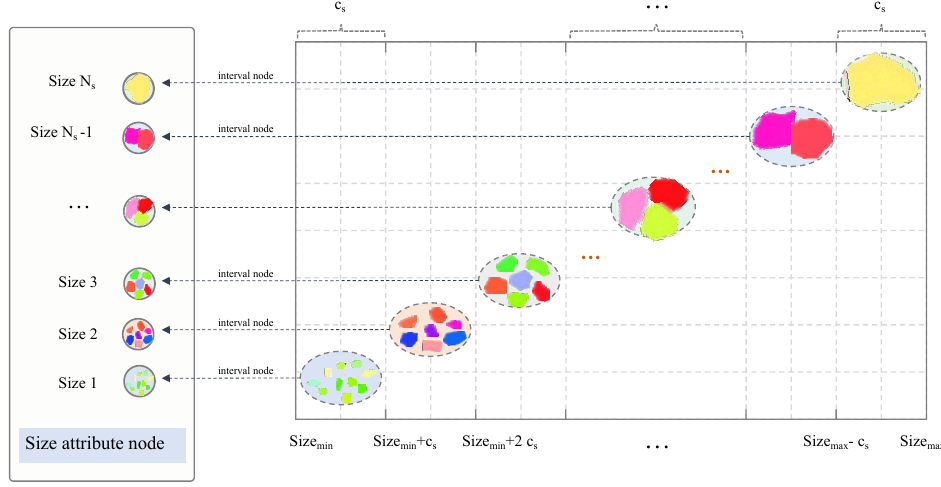
Figure 3. Grain size discretization and size attribute node construction. Size max ( Size min ) denotes the largest-scale grain size (the smallest-scale grain size). According to the interval length c s , the grains are divided into each interval. There are N s intervals in total, N s = each interval, the corresponding node on the left is